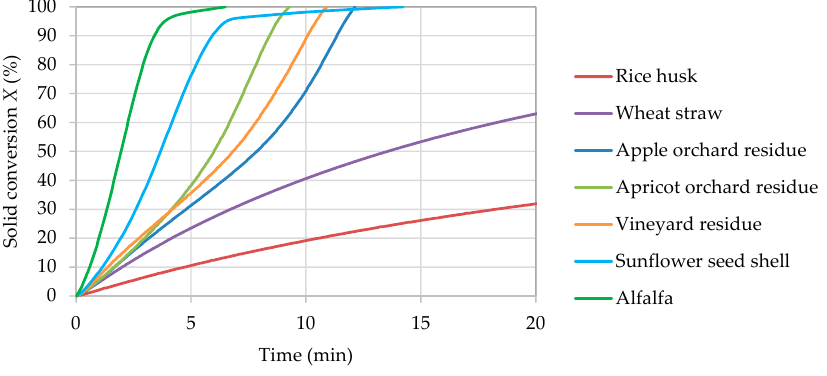
Figure 7. Solid conversion of biomass samples as a function of time during the gasification step (char TGA, 0.05 L·min − 1 mixture 80 vol % N 2 /20 vol % H 2 O, 800 °C). Including data from Dupont et al. [28].